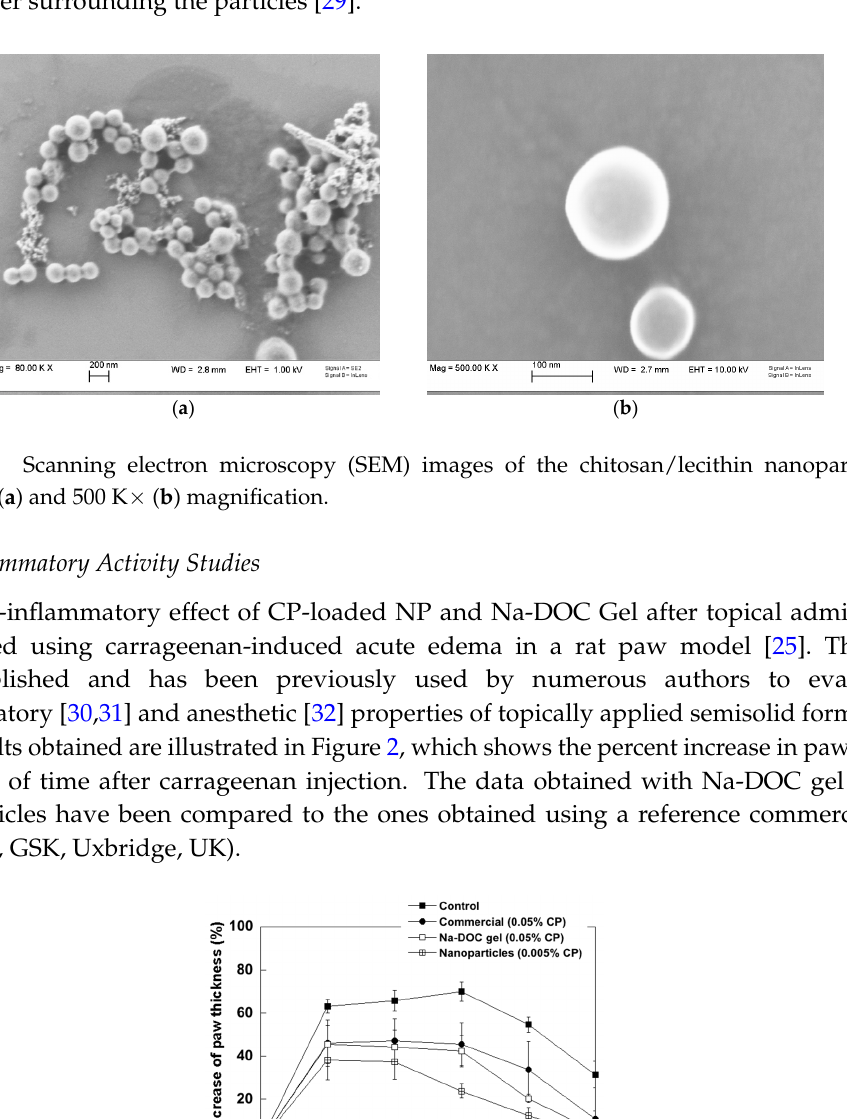
Figure 2. Increase of paw thickness (%) as a function of the time after carrageenan injection.